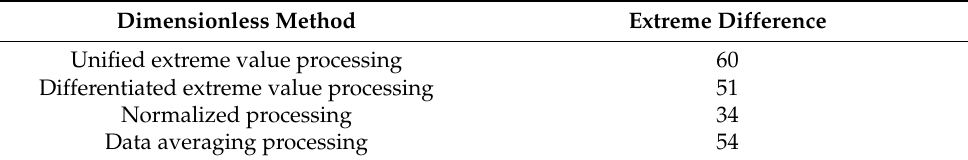
Table 5. Extreme difference values of C for different prediction models under the same dimensionless